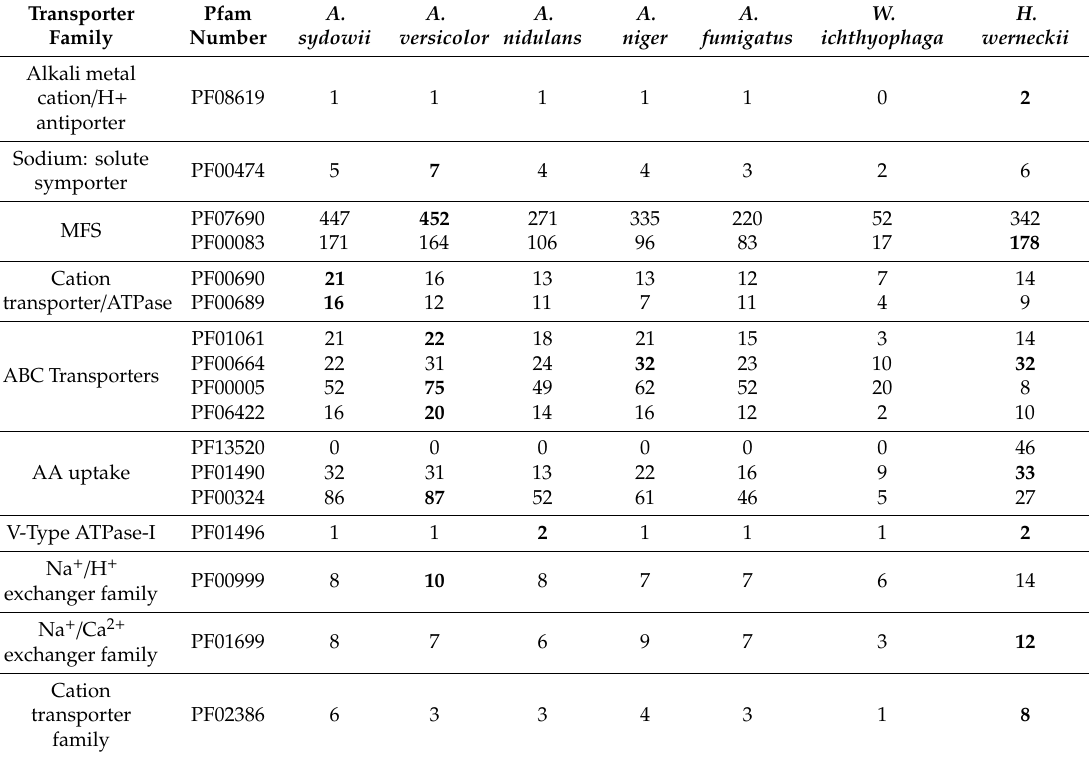
Table 2. Genomic distribution of transporter families within Aspergilli species